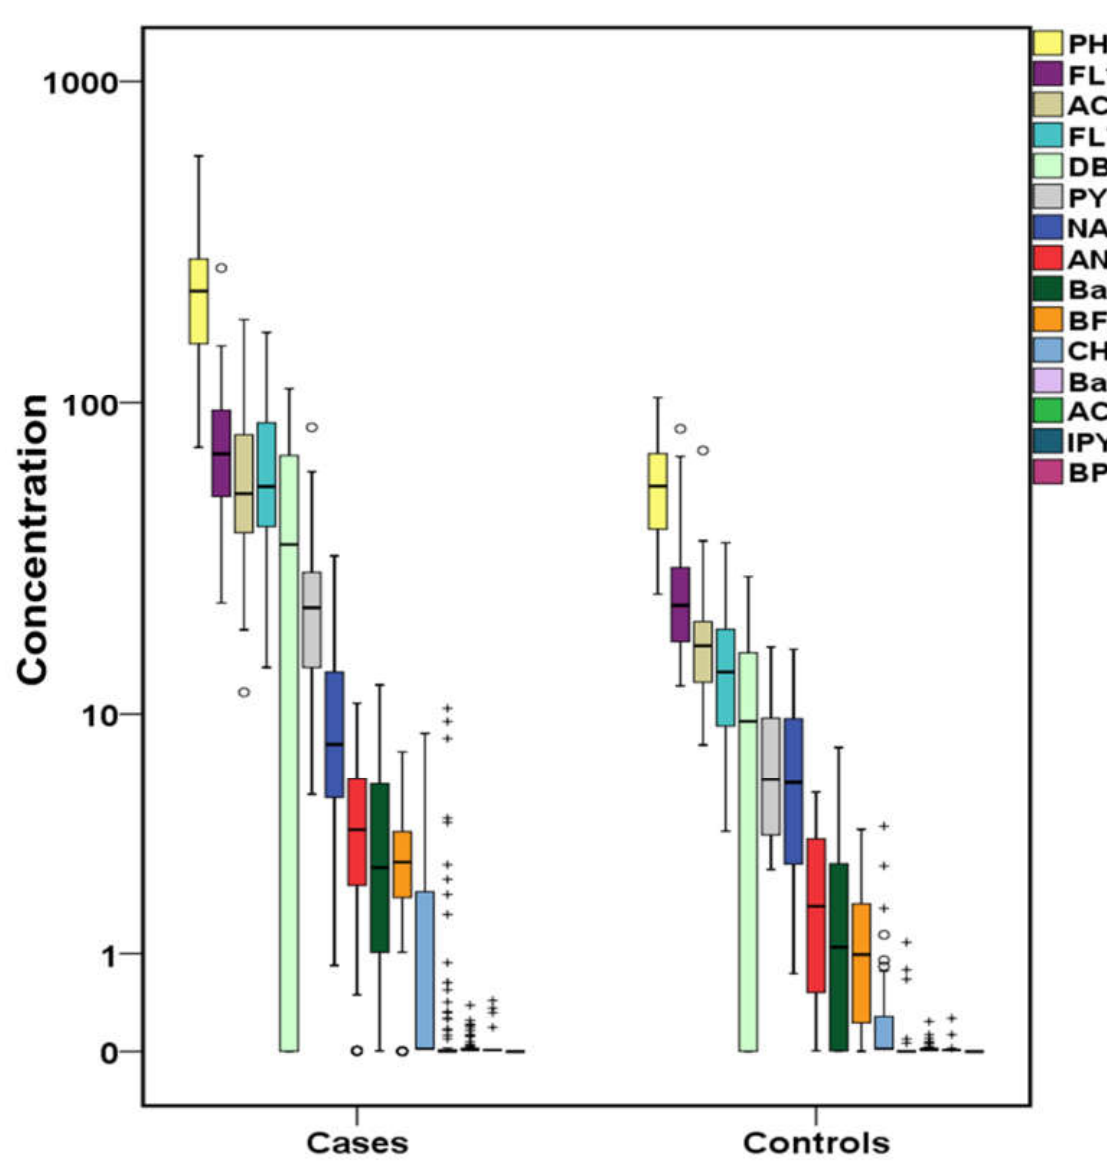
Figure 1. Variation of PAHs ( µ g L − 1 ) both for cases and controls ( + outliers, o values above 3rd quartile and * p -value < 0.05) in logarithmic scale (PHE:phenanthrene, FL:fluorene, ACE:acenaphthene, FLT:fluoranthene, DBA:dibenzo[a,h]anthra- cene,